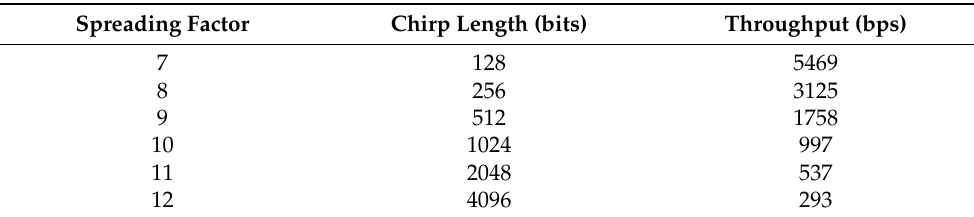
Table 1. Chirp length for each SF used in the LoRa modulation. Spreading